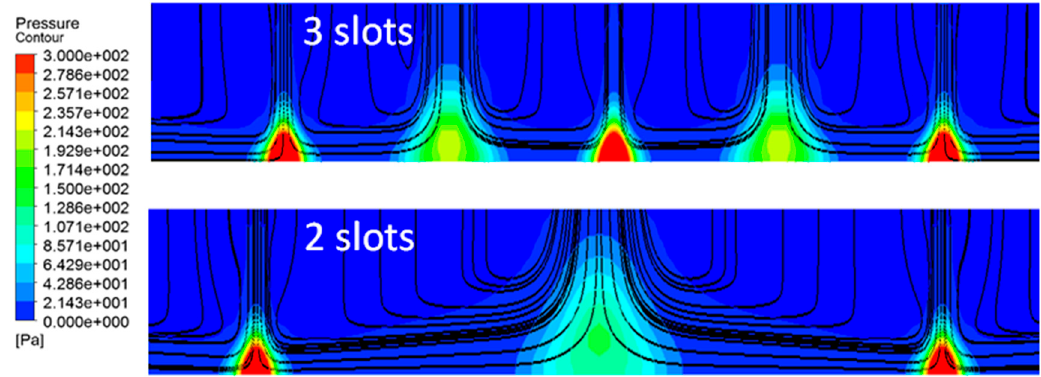
Figure 12. Pressure contours and surface streamlines of multi slot jet configuration with H/B = 4, Re = 5500 and realizable k- ε model: three slots ( upper ) and two slots ( down ).